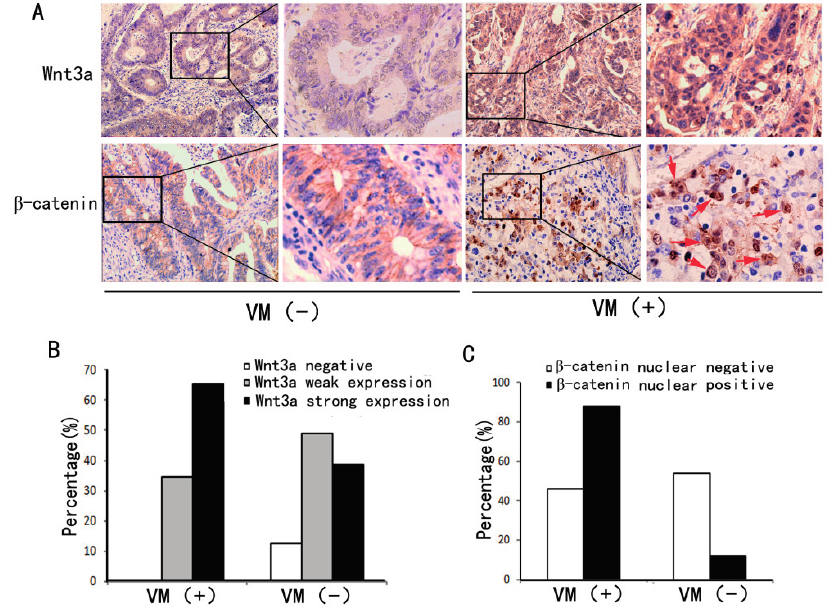
Figure 2. Expressions of Wnt3a and β -catenin in the VM-positive and VM-negative groups. ( A ) Wnt3a expression was higher in VM-positive colon cancer tissue sections ( right ) than in VM-negative samples ( left ). In VM-positive sections, the tumor cells displayed nuclear β -catenin accumulation (red arrows), whereas those in the VM-negative section showed only membranous localization of β -catenin (immunohistochemical staining, ×200); ( B ) Percentages of Wnt3a negative, weak, and strong expression in the VM-positive and VM-negative groups; ( C ) Percentages of β -catenin nuclear positive and negative expression in the VM-positive and VM-negative